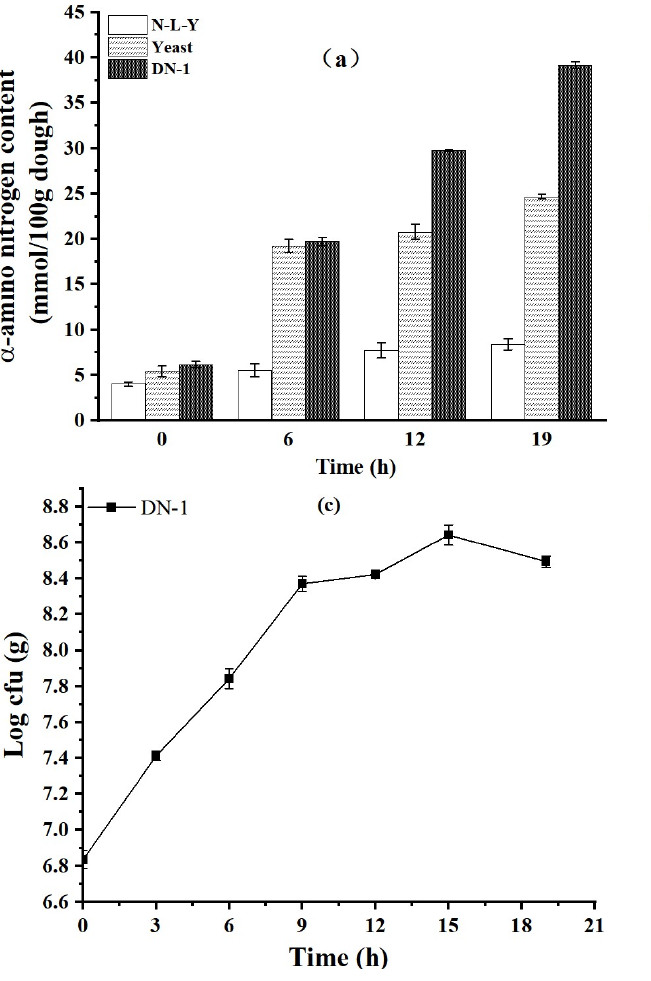
sourdough ( c ), and the growth of yeast in DN-1 and yeast sourdough ( d ) during fermentation.